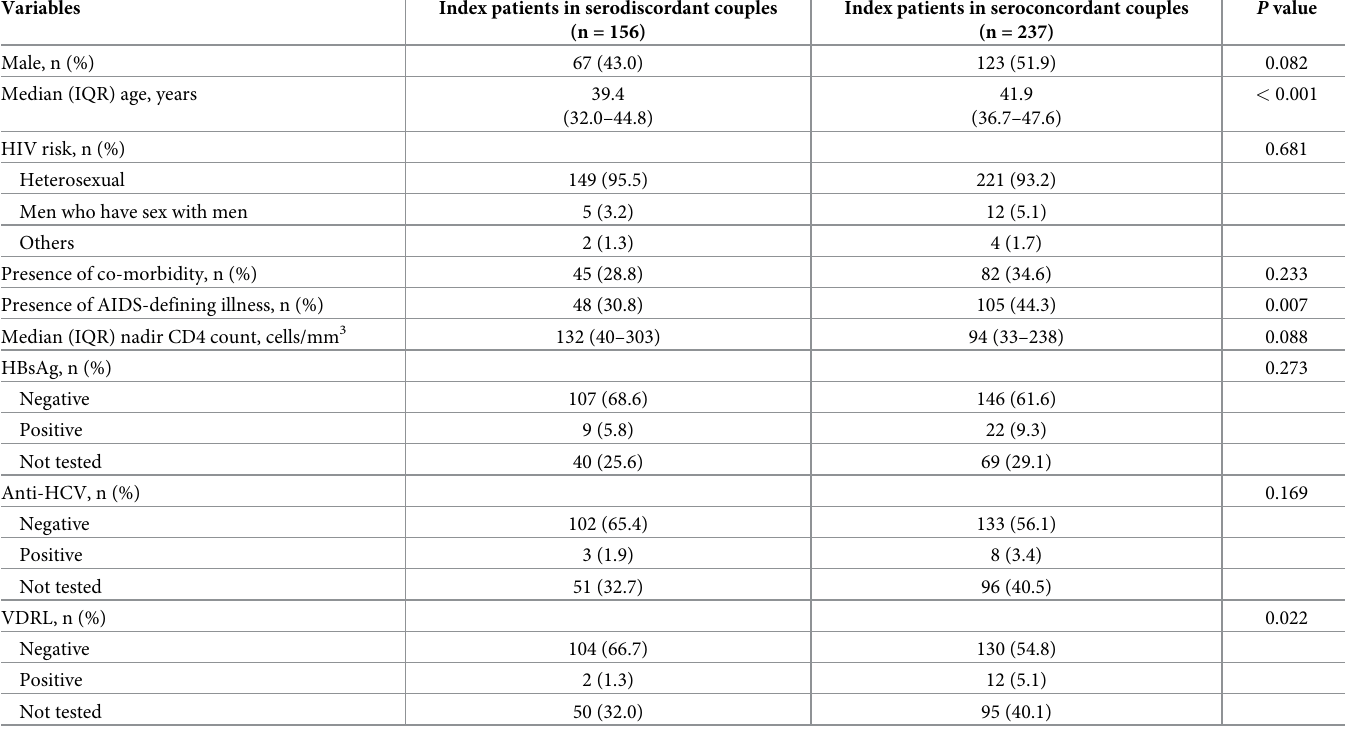
IQR, interquartile range; HBsAg, hepatitis B surface antigen; HCV, hepatitis C virus; VDRL, Venereal Disease Research